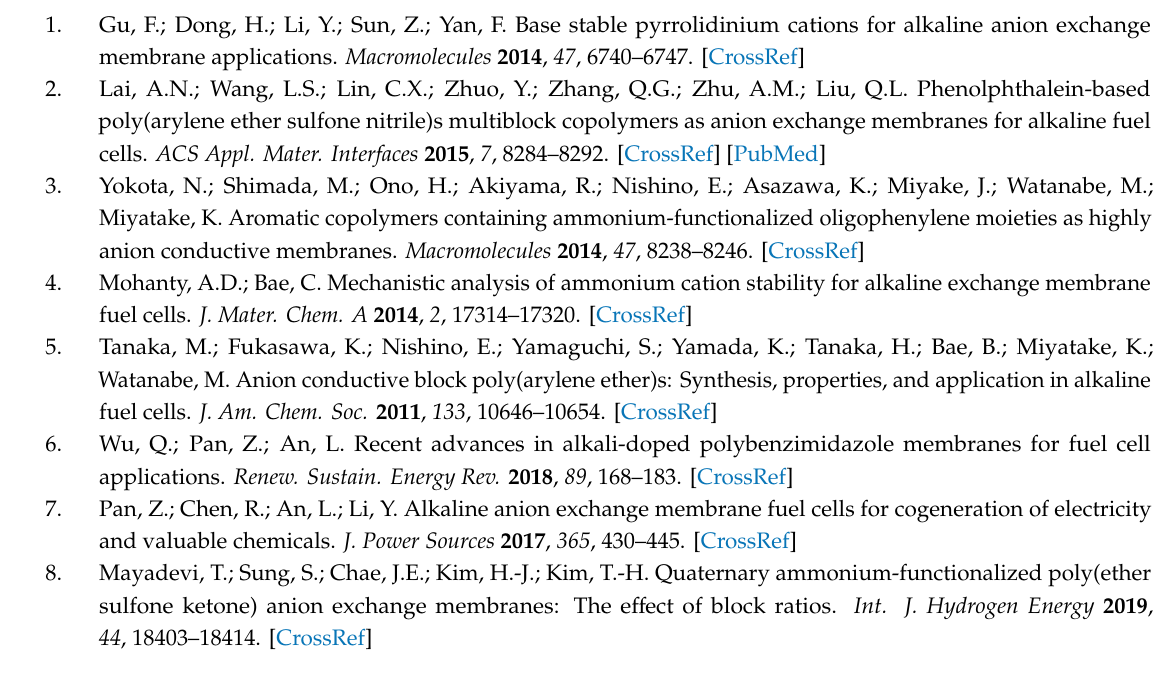
Figure S1: 1H NMR spectra of the m-p -Pip-20 (a), m-p -Pip-50 (b), and m-p -Pip-60 (c) copolymers, Figure S2: 1H NMR spectra of the m-p -MP-20 (a), m-p -MP-50 (b), and m-p -MP-60 (c) copolymers, Figure S3: AFM height images of the m-p -MP-20, m-p -MP-50, and m-p -MP-60 copolymer membranes, Figure S4: AFM 3D images (top view) of the m-p -MP-20, m-p -MP-50, and m-p -MP-60 copolymer membranes, Figure S5: AFM 3D image (side view) of the m-p -MP-60 copolymer membrane, Figure S6: Comparison of the conductivity of the m-p -MP-y membranes with other polyphenylene-type AEMs at room temperature as a function of IEC, Figure S7: DSC plots of the m-p -MP-20, m-p -MP-50, and m-p -MP-60